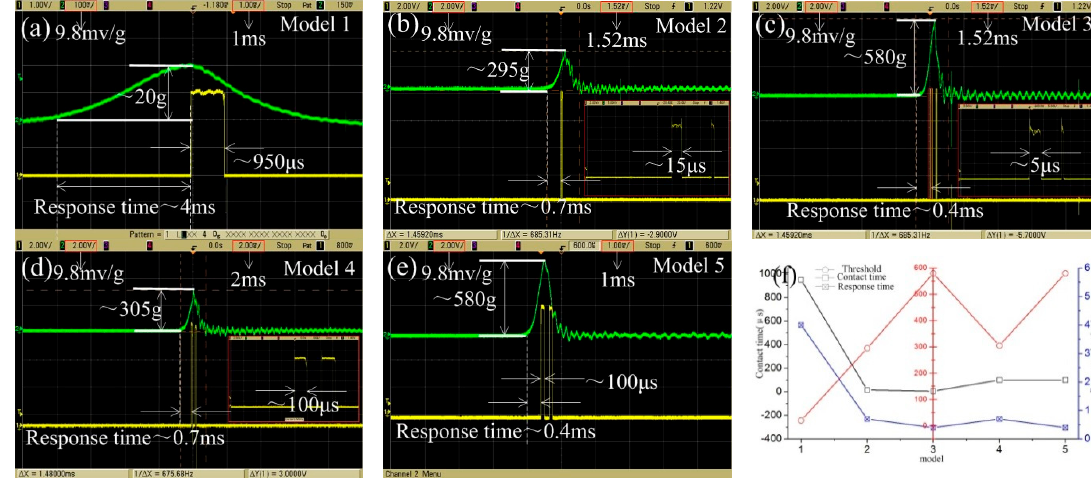
Figure 13. Tested results of prototypes with different thresholds. ( a ) 20, ( b ) 295, ( c ) 580, ( d ) 305, and ( e ) 580 g, and ( f ) curves of the threshold, contact time, and response time. Table 2. Comparative analysis of analytical, simulation, and experimental results.